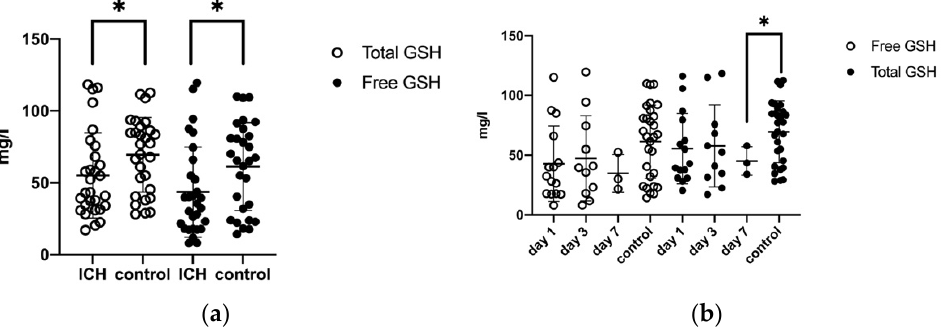
Figure 3. ( a ) Comparison of mean total GSH and free GSH in plasma (P) in ICH patients and control group, free GSH and control: p = 0.02, total GSH, and control: p = 0.03 ( b ) Development of free and total glutathione levels in plasma in ICH patients and the control group (day 1, day 3, and day 7), total GSH (P) at day 7 and control: p = 0.04, ( p = ≤ 0.05 *).